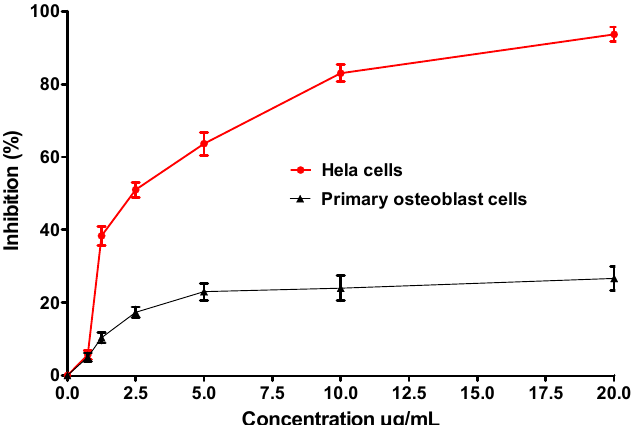
Figure 4. Assessment of GNPs cytotoxicity and determination GNPs IC 50 on cancer cells. Normal human primary osteoblasts and human cervical cancer cell (HeLa cells) were plated overnight at a density of 1 × 10 4 cell per well in a 96-well plate at 37 °C. The normal or cancer cells were treated with different concentrations of GNPs and the in vitro cytotoxicity was evaluated using MTT assay. The inhibition percentages were calculated relative to negative control and IC 50 was the GNPs concentration, which inhibits 50% of HeLa cells. The experiment was conducted in triplicate and the data shown are the means ± standard errors.